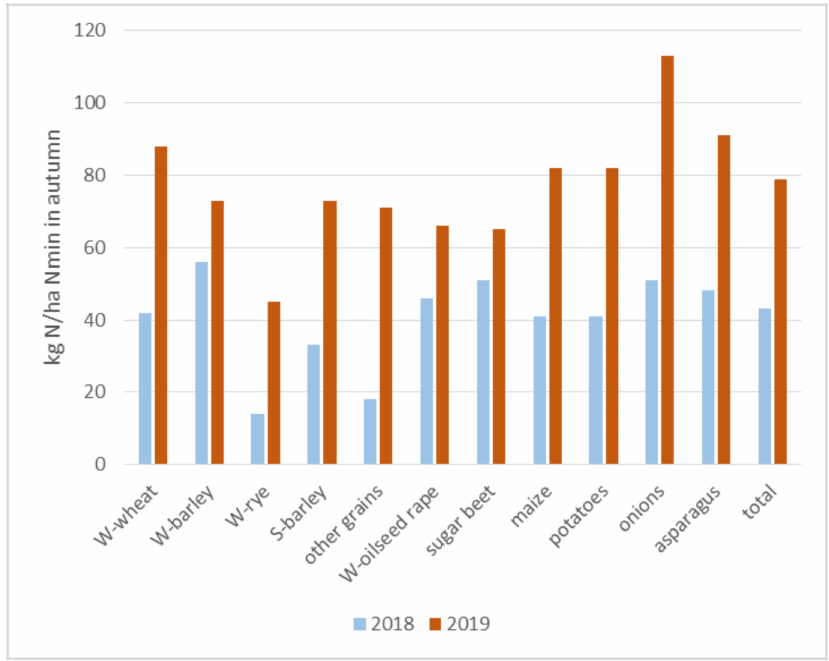
Figure 5. Spring N min -values in 2018 and 2019 (0–90 cm depth) with reference to the preceding crop [47]; average increase in N min -value of 36 kg / ha (source: [48], adapted and